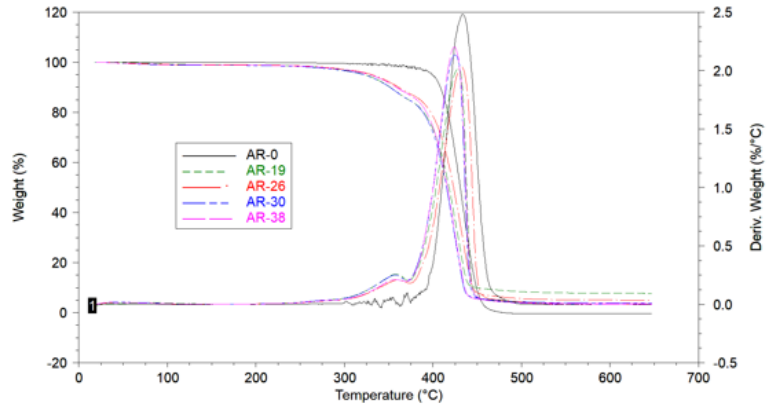
Figure 5. Typical TGA degradation curves of both neat PCL matrix samples (AR_00) and HF/PCL biocomposite samples (AR_19, 26, 30 and 38), showing the effect of fiber on the degradation properties of the HF/PCL samples.